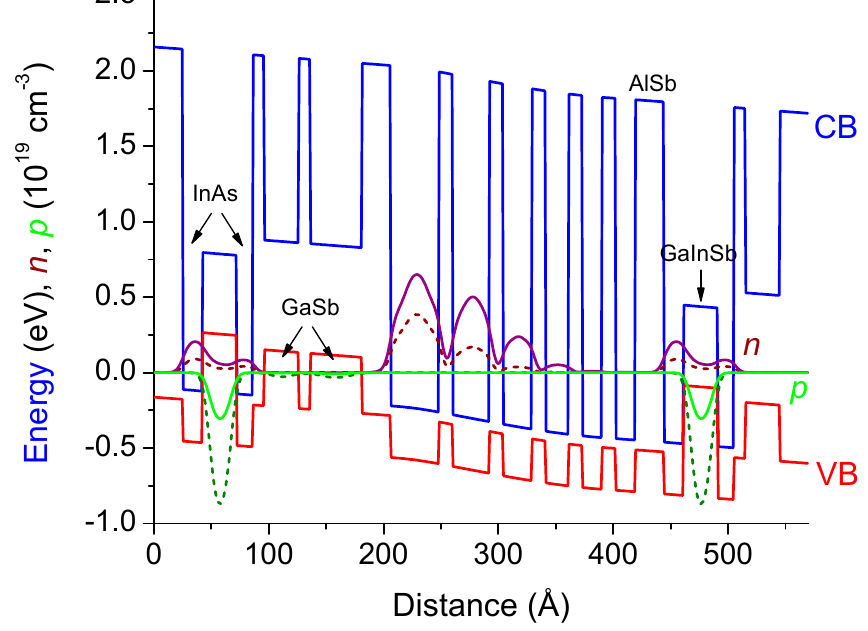
Figure 3. Calculated quasi-equilibrium electron (wine-colored) and hole (green) density distributions for ICL designs without carrier rebalancing (dashed), and with the carriers rebalanced (solid) by doping four of the InAs electron injector QWs with Si to 5 × 10 18 cm − 3 . The blue and red lines indicate the conduction- and valence-band bulk band edges, respectively. Adapted from Ref.